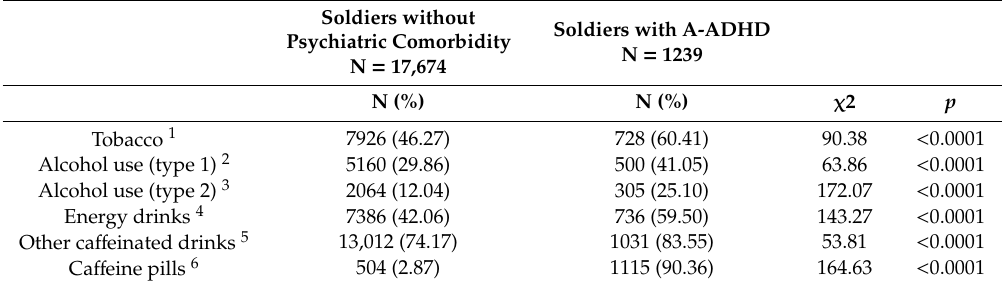
Table 3. Per week substance use in A-ADHD soldiers and those without any psychiatric